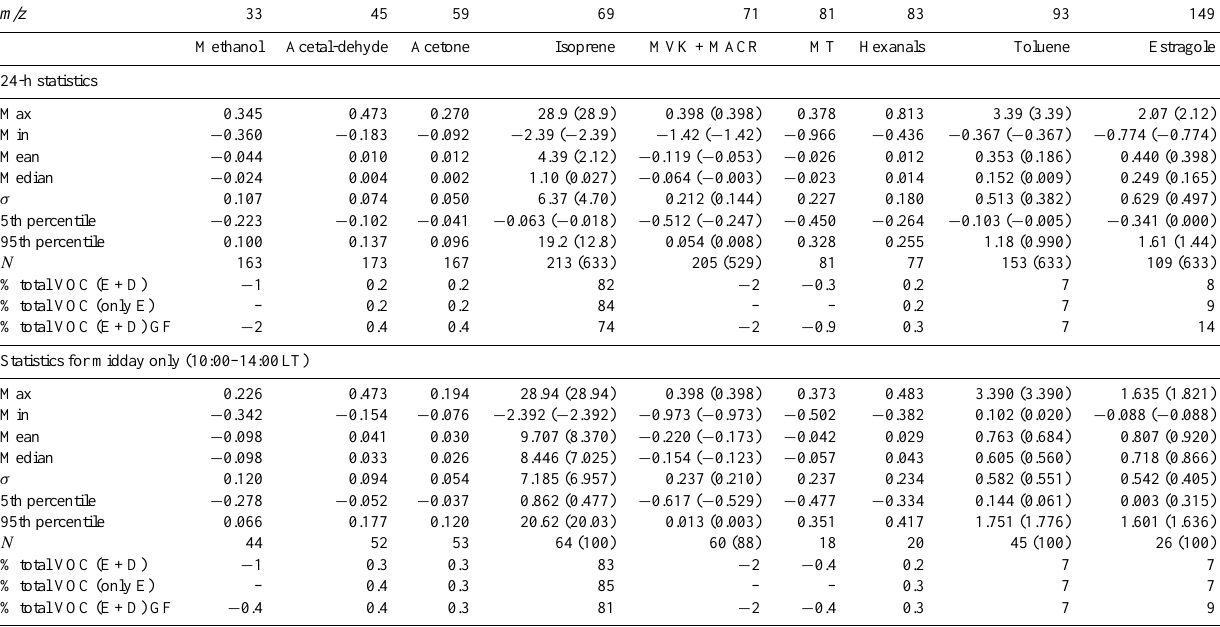
Table 2. Summary statistics for eddy covariance BVOC fluxes above the oil palm plantation (total measurement period and midday). In parentheses are given statistics values for fluxes gap-filled using approaches discussed in Sect. 3.5; E – emission, D – deposition, GF – gap-filled (note only Isoprene, Estragole, Toluene, and MVK+MACR were